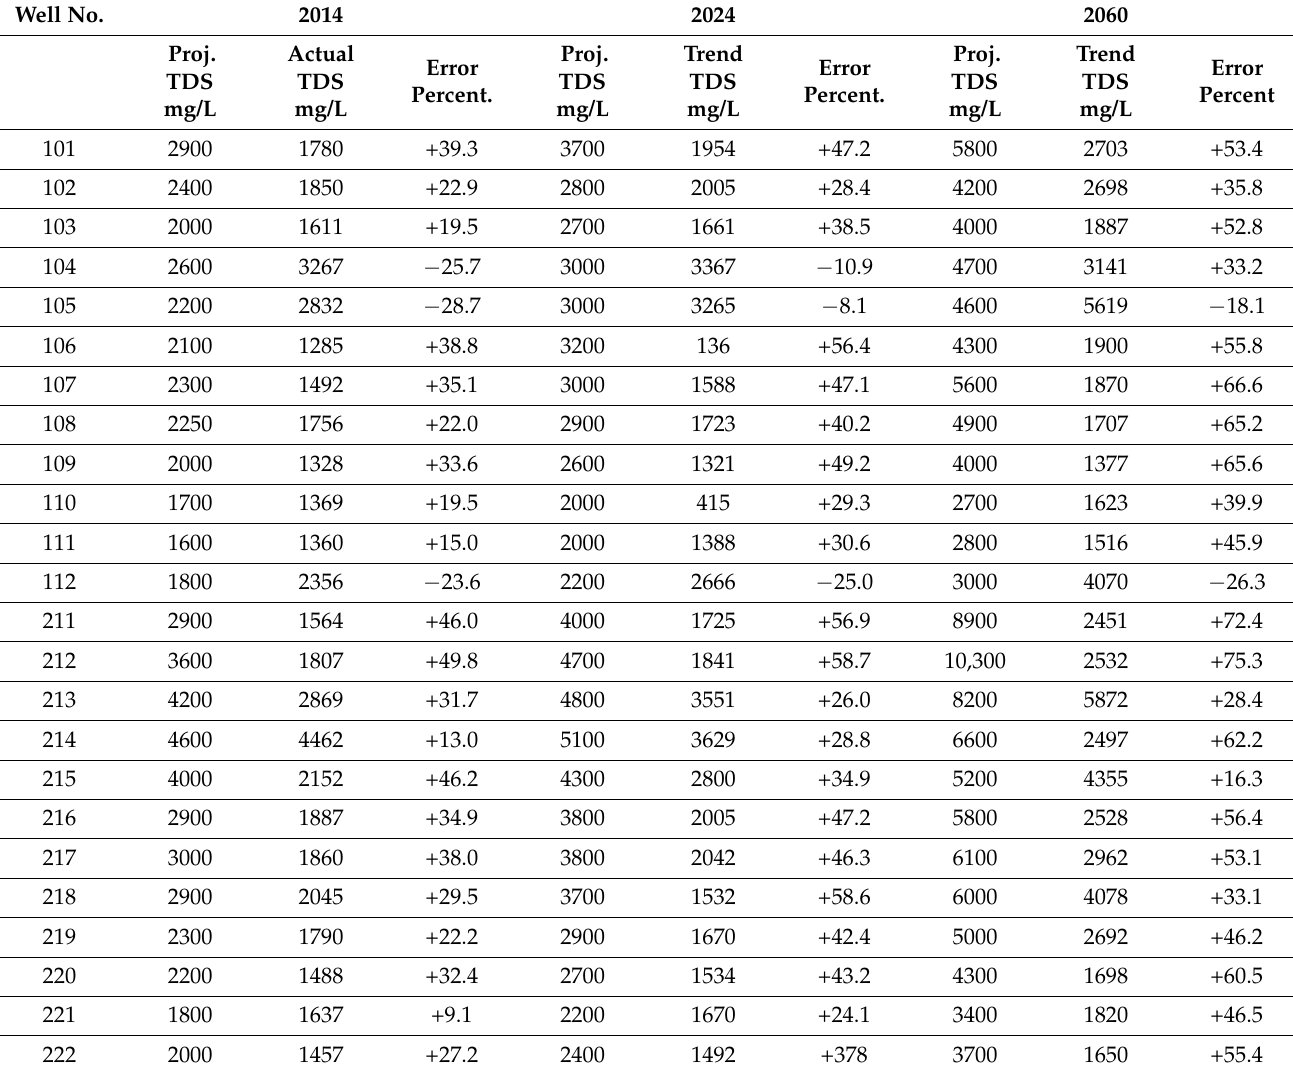
Table 4. Comparison of the measured and projected data from the linear regression analyses to the MWH individual well projections [13]. Well